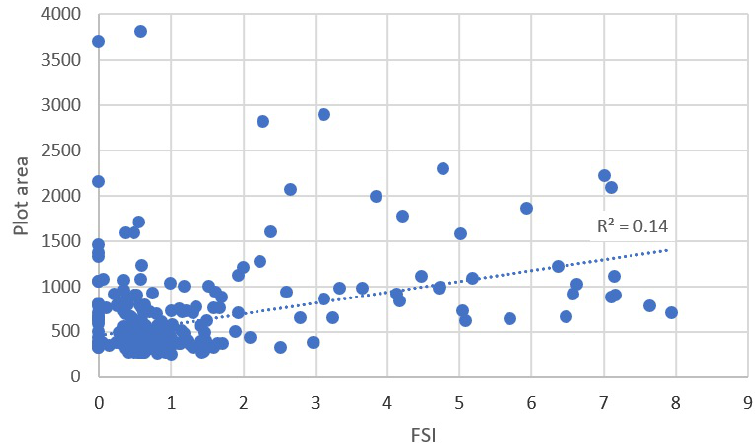
Figure 7. Chart with relation between FSI and plot area per plot.